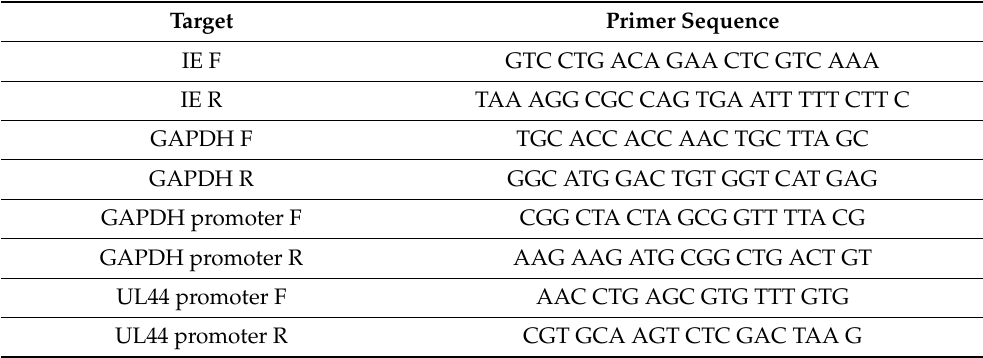
Table 2. Primers used in qPCR and